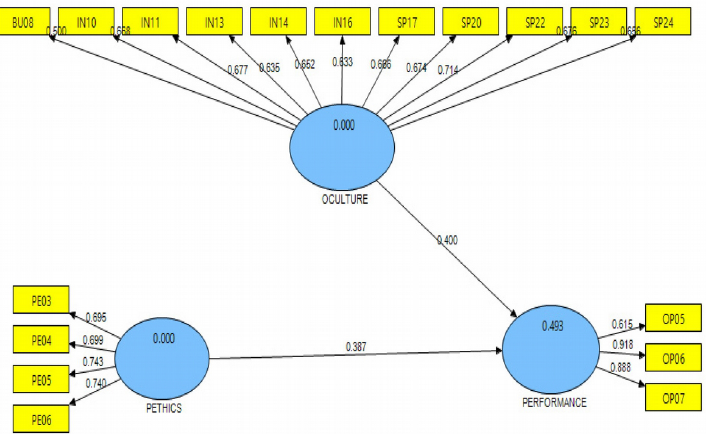
Figure 2. Measurement